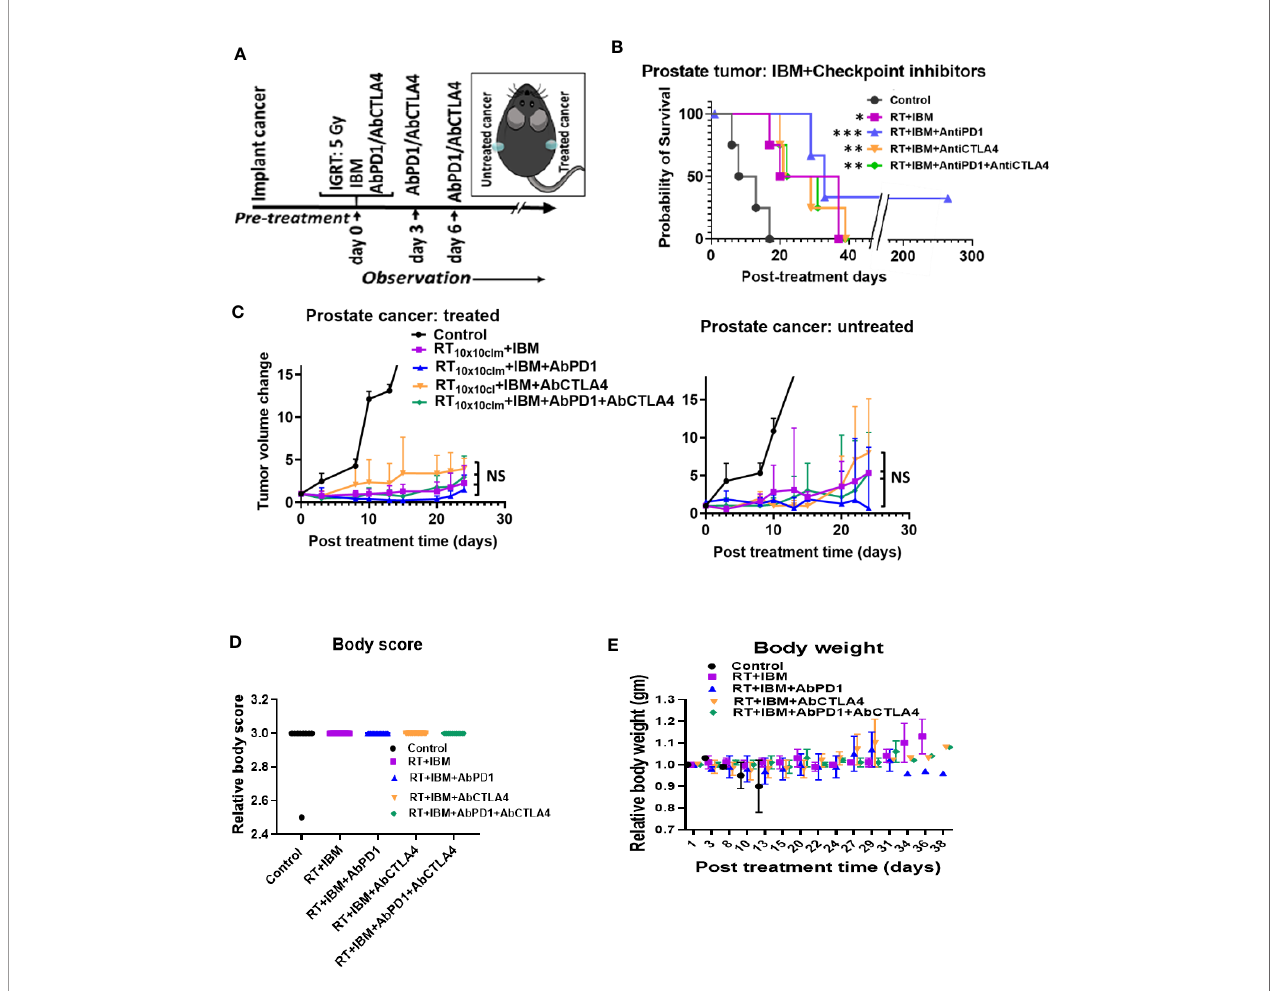
FIGURE 4 | IBM further enhance the survival duration in combination with anti-PD1 and anti-CTLA4. (A) Research design to treat prostate cancers adding anti-PD1 and anti-CTLA4 antibody (IP) with the RT+IBM treatment. One treatment of IBM was given intratumorally (IT) in one out of two implanted tumors following 5 Gy IGRT in the same cancer on day 0. Anti-PD1and/or anti-CTLA4 was given intraperitoneally (IP) on days 0, 3, and 6. (B) Kaplan-Meier survival curve and (C) line graphs of dynamics of tumor volume change of both treated (left) and the other untreated/metastatic cancers (right) of this study with 5 Gy of IGRT+IT IBM followed by IP injection of anti-PDL-1 and/or CTLA4. (D, E) representing graph showing body score and body weight of the same cohort groups. All statistical signi fi cance was compared with controls. * p < 0.05, ** p < 0.01, *** p < 0.001; NS, not signi fi